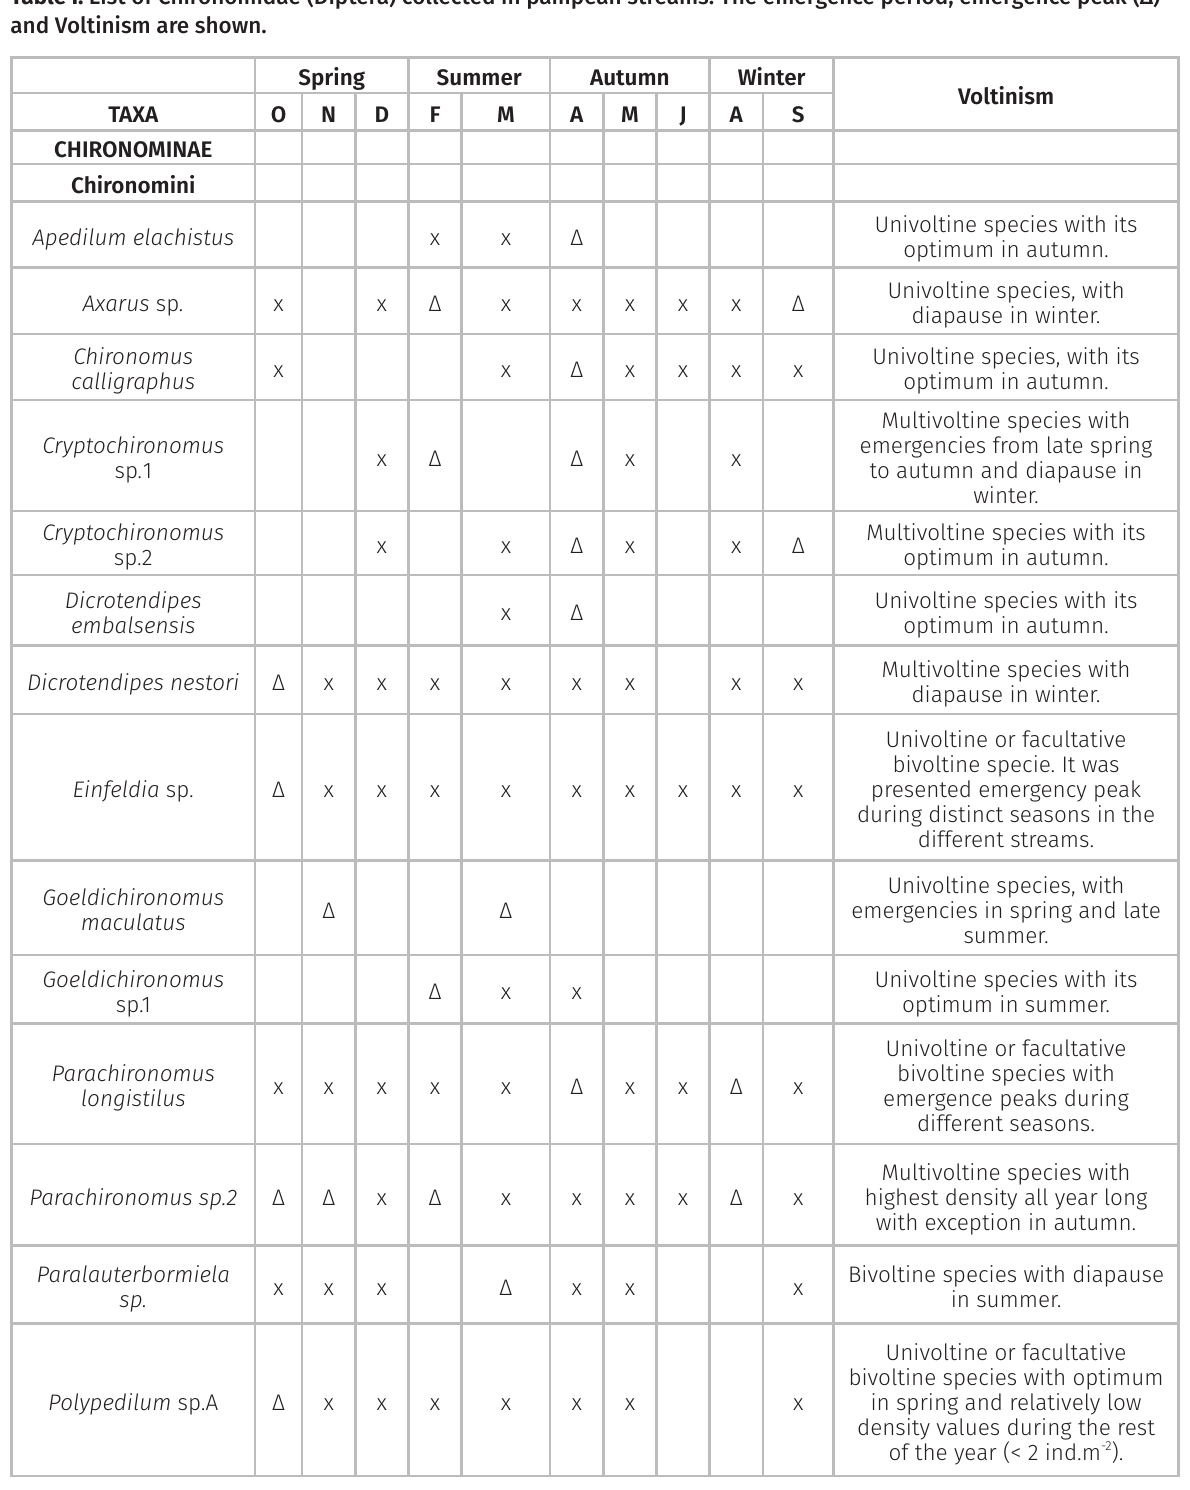
of the year (< 2 ind.m -2